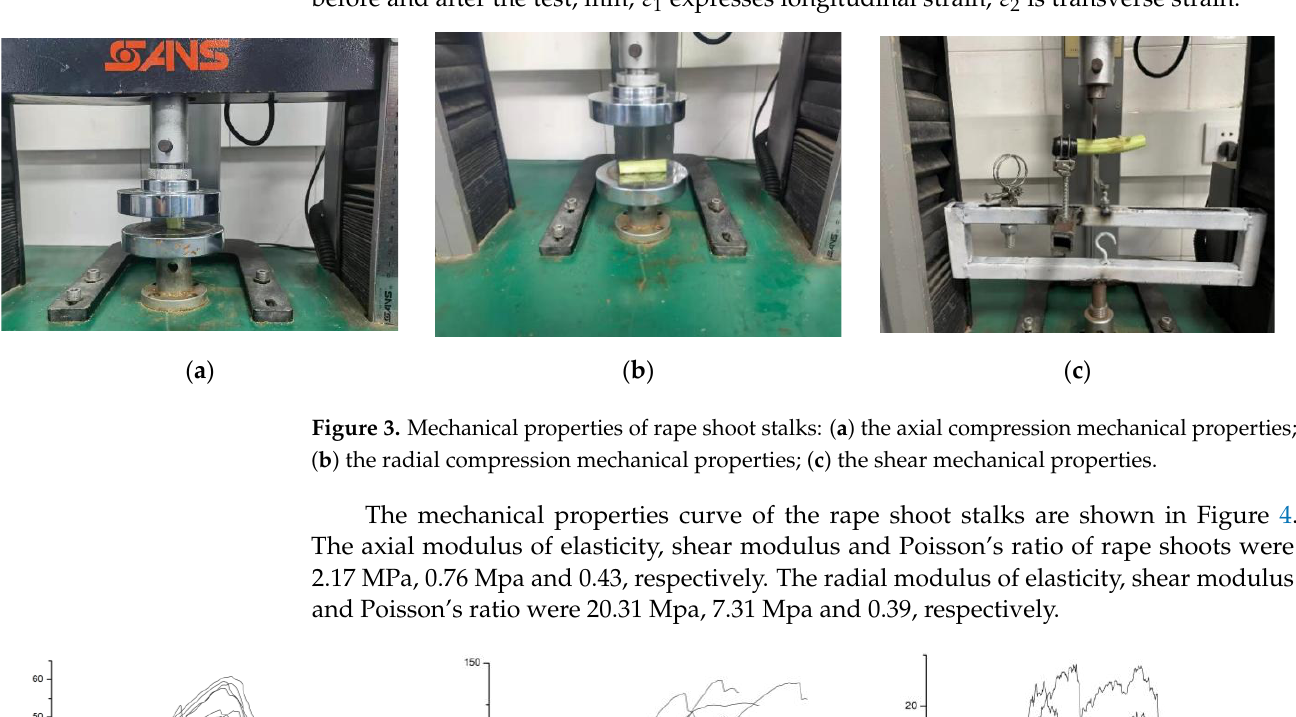
Figure 3. Mechanical properties of rape shoot stalks: ( a ) the axial compression mechanical proper- ties; ( b ) the radial compression mechanical properties; ( c ) the shear mechanical properties.